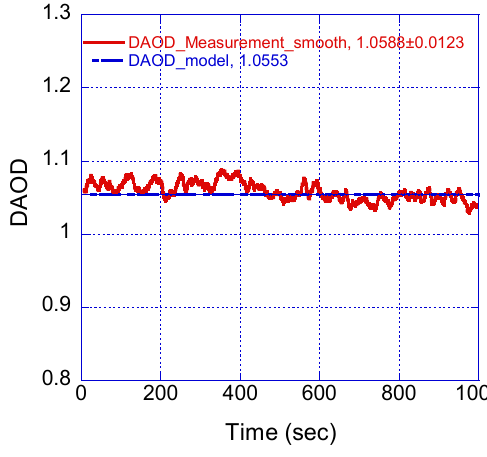
Fig. 2b. DAOD measurement by the IPDA lidar. The measurement is the result of 10s (100 shots)